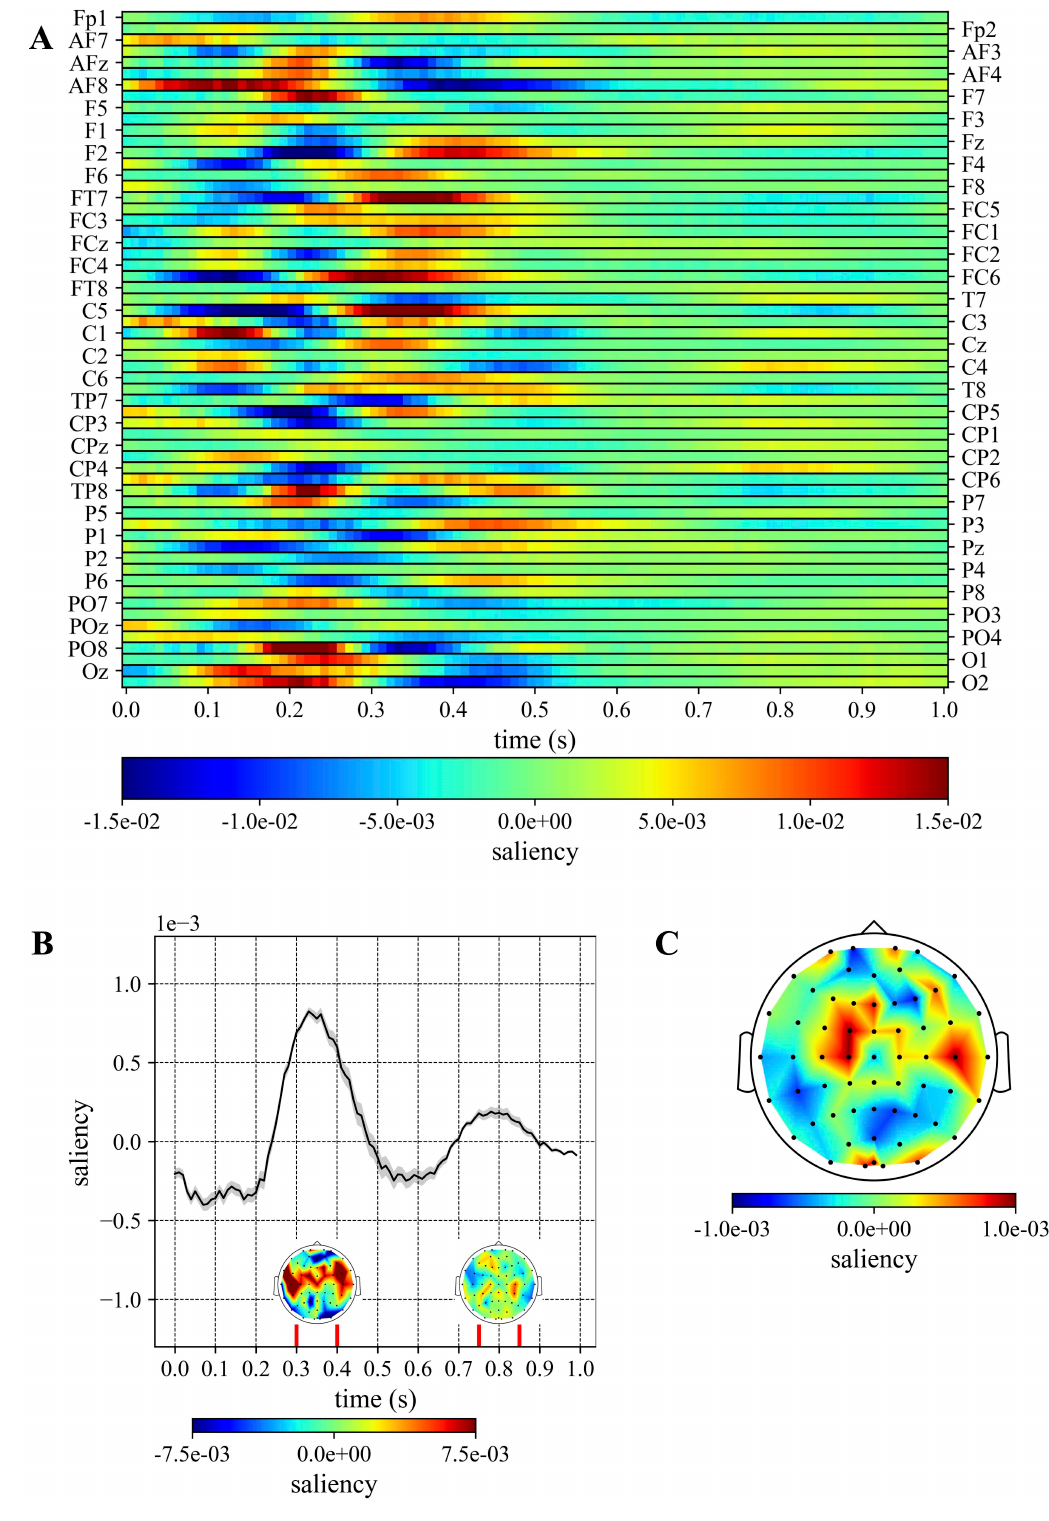
Fig. 7. Cross-subject saliency: distractor. (A) The 2D cross-subject saliency map is reported as a heatmap. (B) Temporal cross-subject saliency pattern, obtained by averaging the 2D saliency map across all electrodes. The time intervals where the saliency is higher are denoted by vertical red lines. For these specific intervals, the topological representation of the spatial cross-subject saliency pattern is also reported, obtained by averaging the saliency values of each electrode within each time interval. (C) Topological representation of the spatial cross-subject saliency map, obtained by averaging the saliency values of each electrode over the entire epoch (0–1000